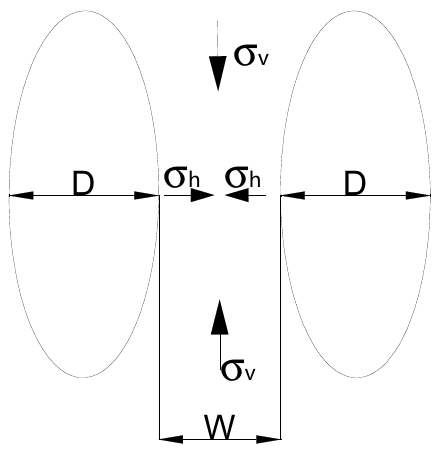
Figure 6. Schematic diagram of the double-cavern model.